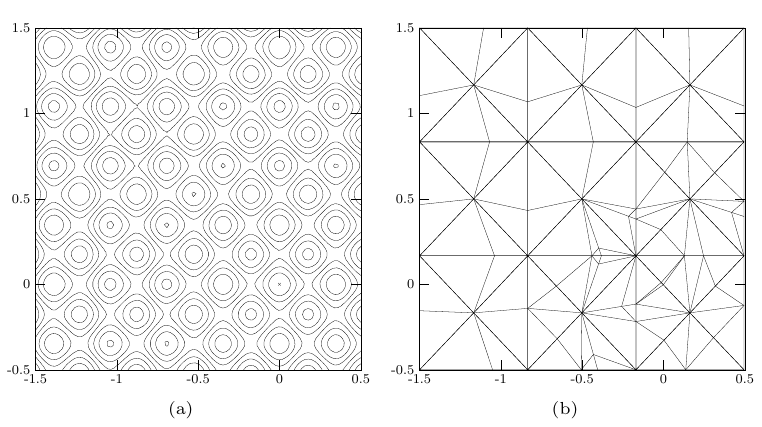
Figure 1. The Rastrigin function presented by contour lines and the simplicial covering of the feasible region after termination with Δ = 0 . 1 d With the parameter defining the very rough termination condition Δ = 0 . 1 d , where d is the length of the diagonal of the feasible region, the algorithm has stopped after 71 computations of the objective function values. The best found value was − 1 . 9986 and the distance between the best found point and the true solution point was 0 . 001 d . The simplicial covering of the feasible region after termination is shown in Figure 1b. Such a fast location of the global minimizer with a high precision can be considered as occasional. However, the continuation of search (by decreasing Δ ) shows rational concentration of points in the attraction regions of the main local minima. In the case of Δ = 0 . 05 d the algorithm stopped after 182 computations of the objective function values, and the simplicial covering is shown in Figure 2a; the previous approximation was not improved. The distribution of 361 point where the objective function values were computed before stopping with Δ = 0 . 03 d are shown in Figure